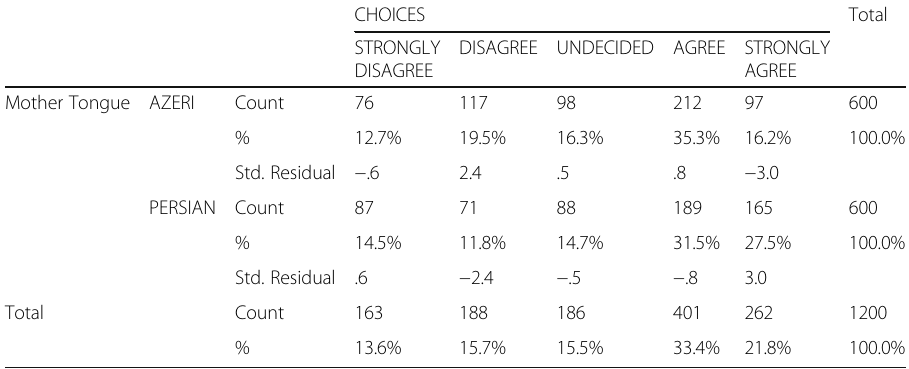
Table 4 Frequencies, percentages and standardized residuals of the teachers ’ perceptions towards explicit grammar instruction and corrective feedback